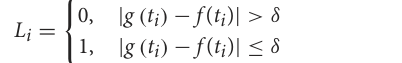
FIGURE1 (A) Experimental scene. (B) The interface of visuomotor force-control task. During the training, the participants were required to product a force (red line) matching the preset force (green line) through visual